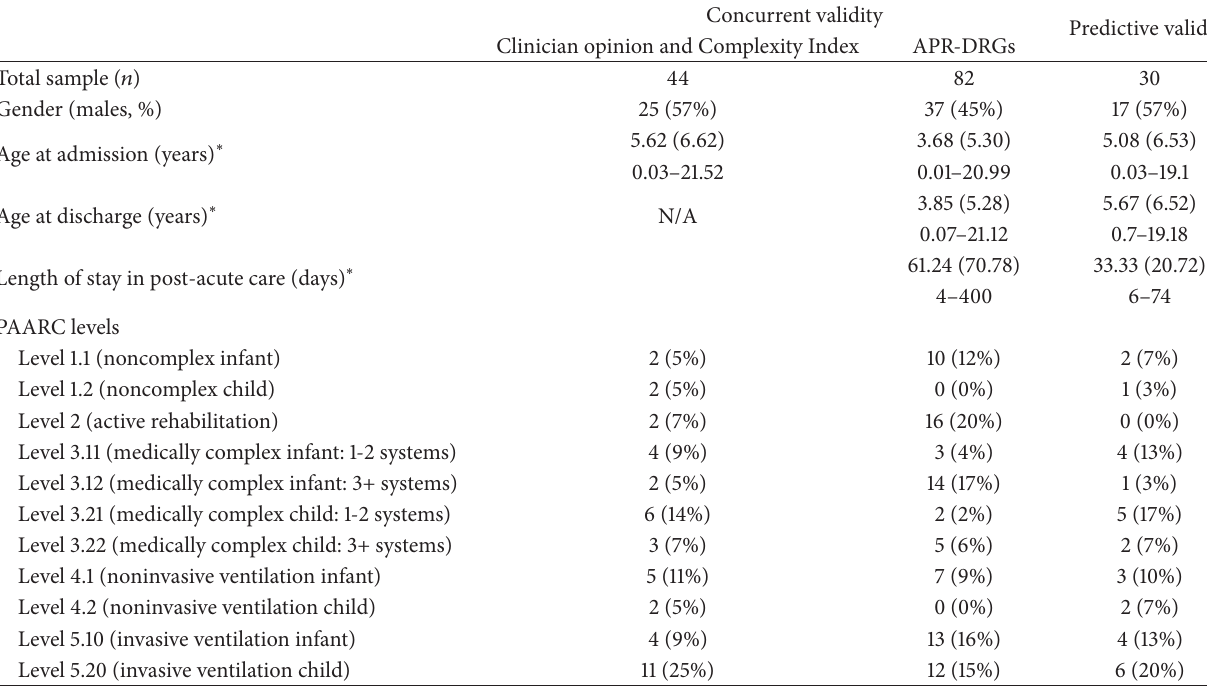
Table 2: Characteristics of samples for concurrent and predictive validity